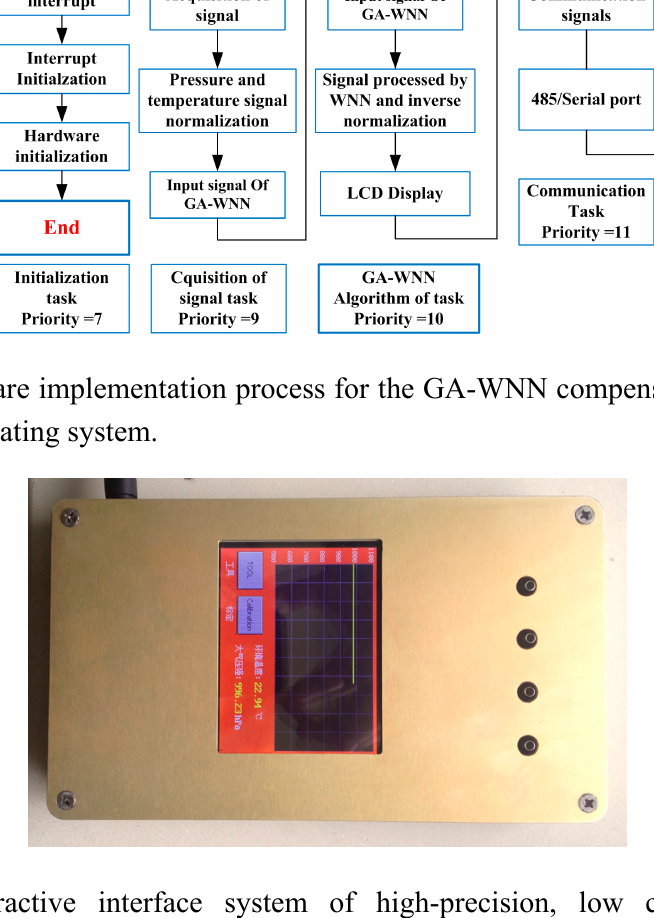
Figure 13. Interactive interface system of high-precision, low cost piezoresistive MEMS-array pressure transmitter based on the μC/OS and μCGU